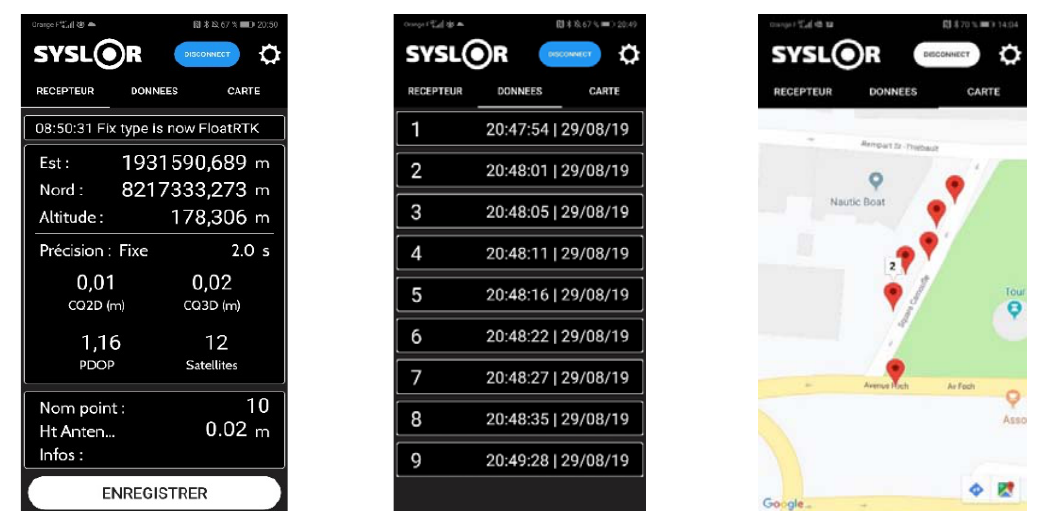
Figure 9 : Syslor field notebook Android application for GNSS